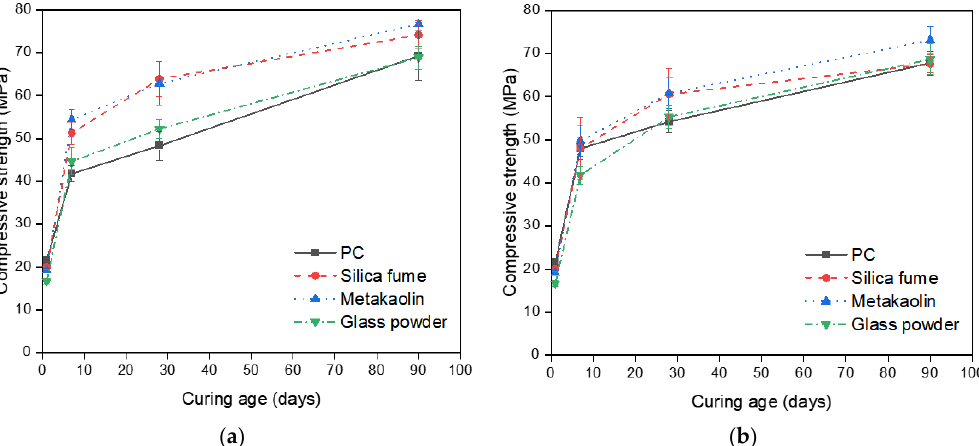
Figure 5. Compressive strength development of samples: ( a ) Measured strength values of samples cured in tap water; ( b ) Measured strength values of samples cured in seawater. Table 5. Measured compressive strength.